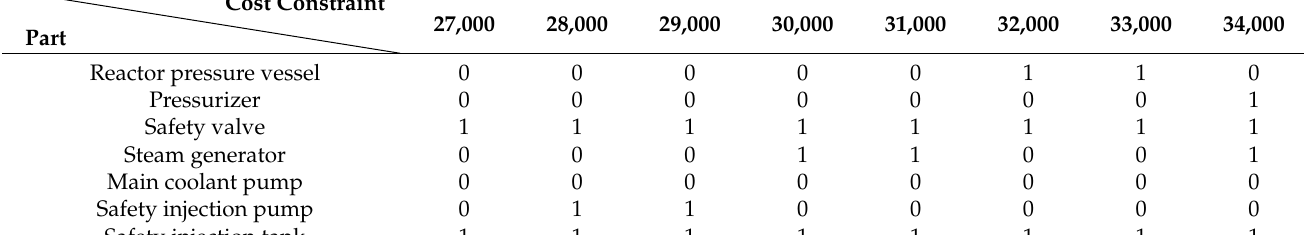
Table 7. X10, X11, X13 failures, t = 1000 h.